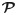
The minimize area circle for set P: The triangles are the sampling point set P={p0,p1,…,pn}.The concentric circles C1 and C1′, with the center point O1, are capable of containing all the points in set P. The radiuses of C1 and C1′ are r1 and r1 + ε1, respectively. The radius of the maximum inscribed circle C2 is r2, and its center point is O2. The shortest distance of set P from O2 is r2 + ε2.